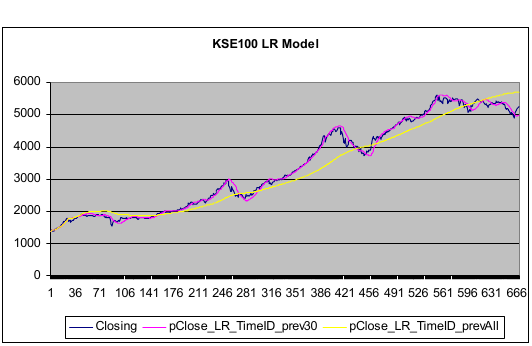
Figure 3: KSE100 SLR